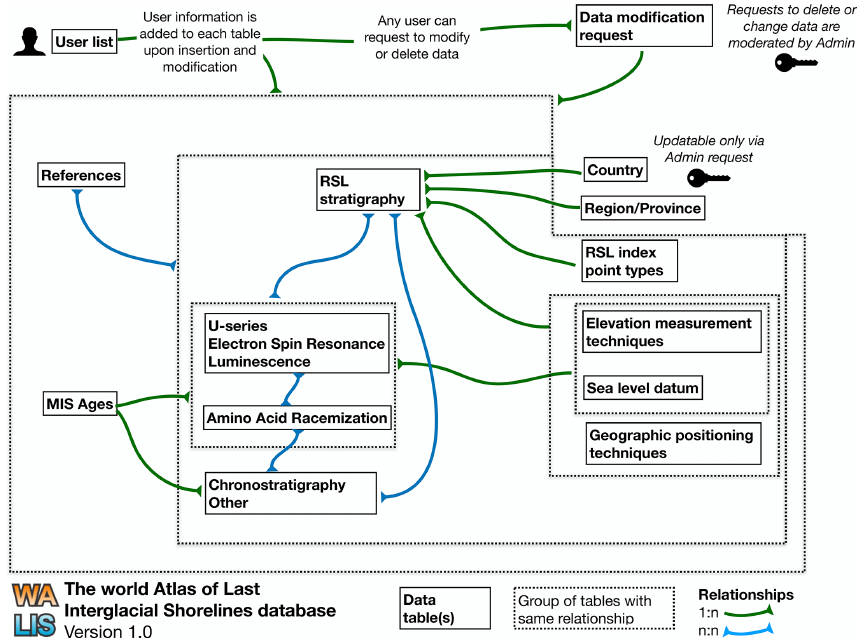
Figure 3. Database structure for WALIS. Note that the relationships among tables are managed via the PHP interface and are, therefore, not included in the database. Also not included in this scheme are the tables to report Holocene data, which are still in beta testing.